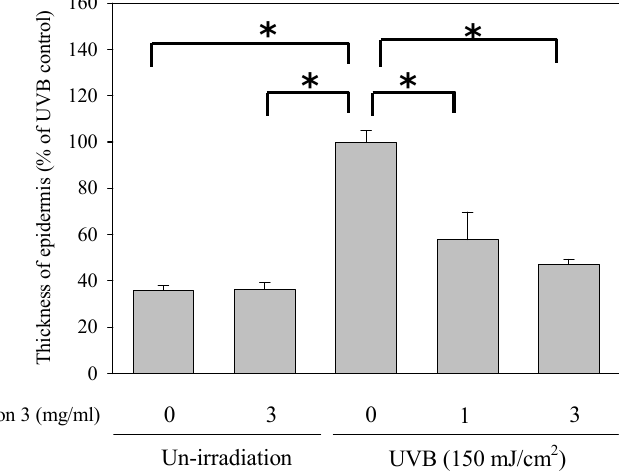
Figure 4. Fraction 3 inhibits UVB-induced epidermal proliferation, * p <